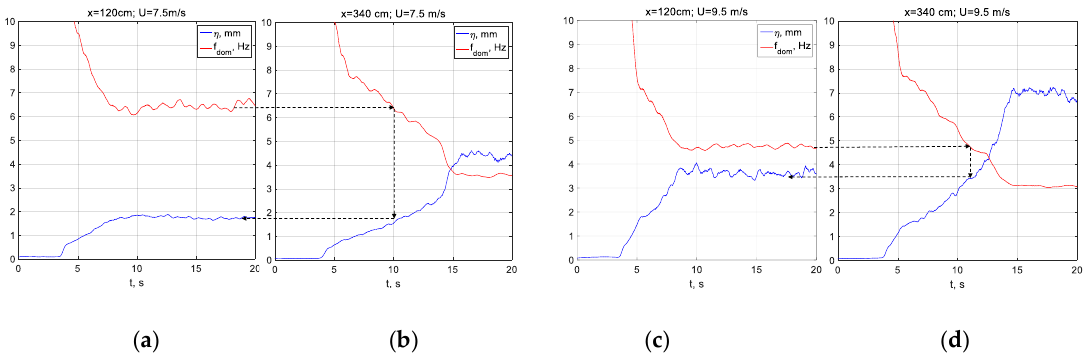
Figure 24. Comparison of the temporal variation of the ensemble-averaged wave amplitudes and the characteristic dominant frequencies at two fetches and two wind velocities. The broken lines indicate the steady-state values at the shorter fetch. Panels ( a ), ( b ) correspond to two fetches at U = 7.5 m/s; panels ( c ),( d ) show the amplitudes at the same fetches for U = 9.5 m/s